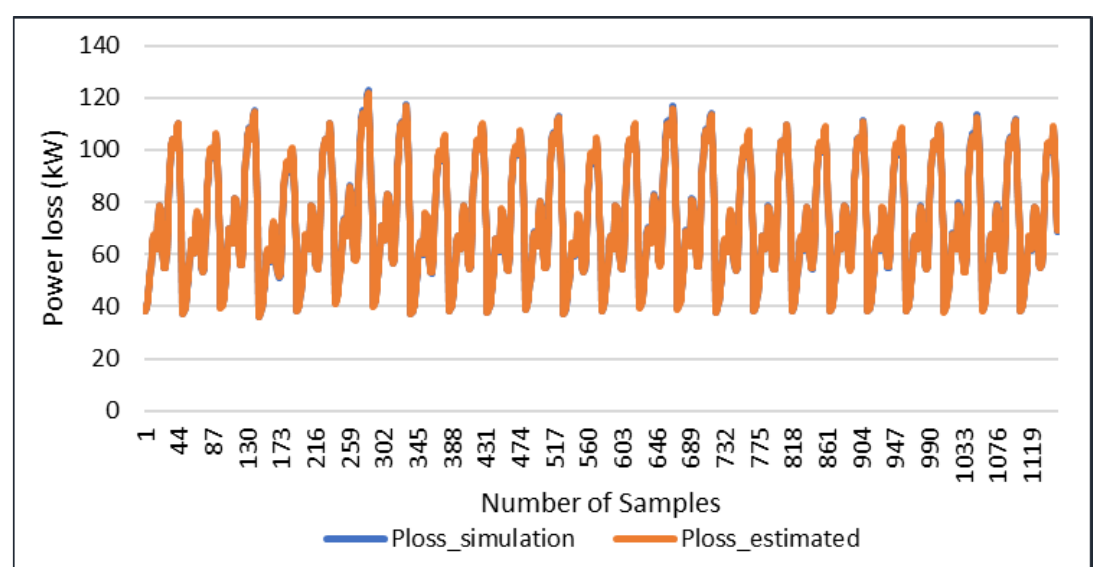
Figure 5. Active power loss obtained from function 2.